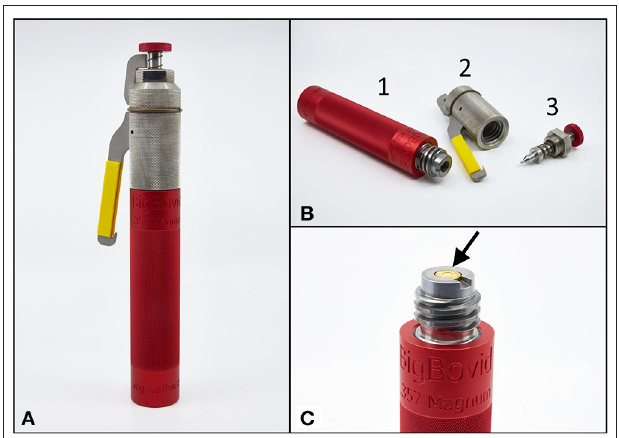
FIGURE 1 | (A) In shape and size (total length: 280mm) the BigBovid looks like an ordinary captive-bolt stunner. (B) The device consists of three parts, namely the barrel (1), the trigger (2), and the firing pin (3). (C) To insert the cartridge into the chamber (arrow), the upper silver end is unscrewed from the lower red end. The two parts are then screwed together again for use on heavy cattle.